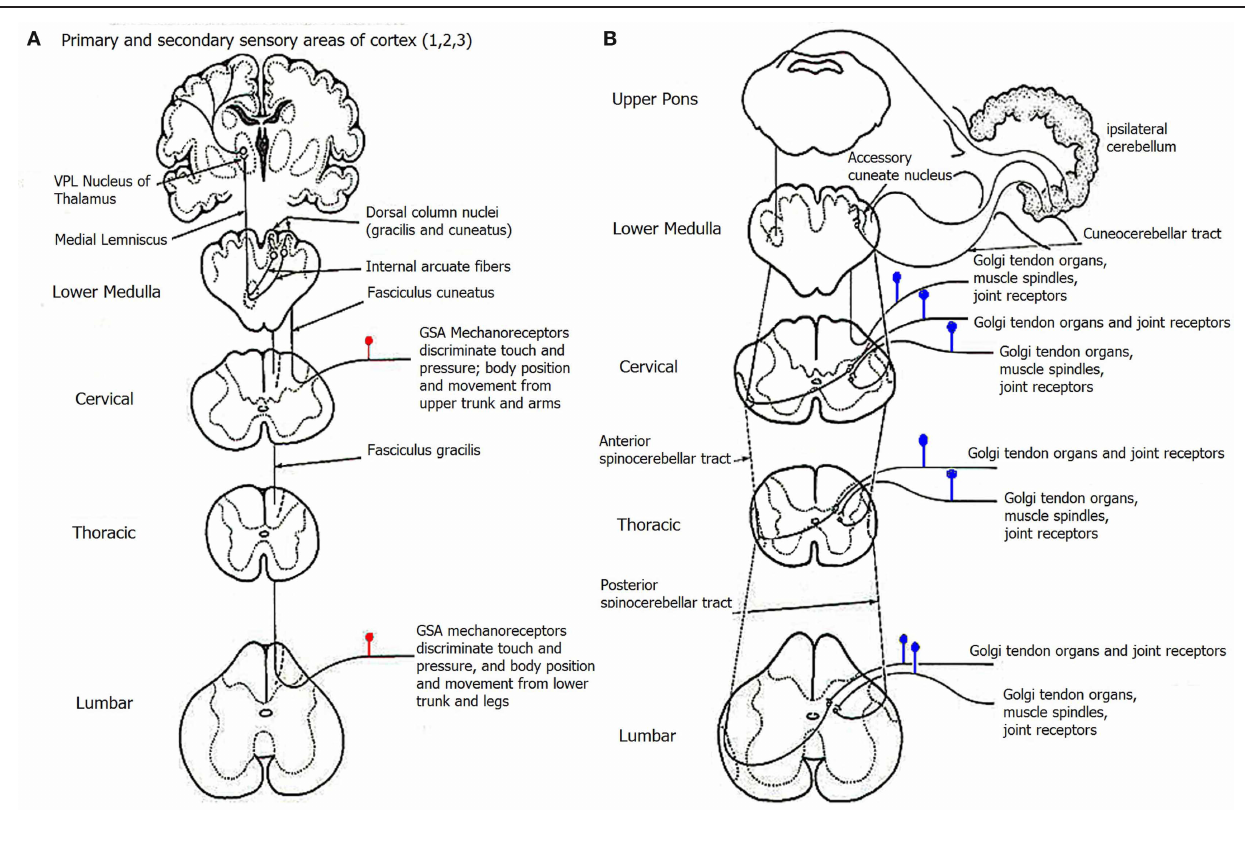
somatosensory cortices (Broadman areas 1, 2, and 3). (B) The so-called unconscious proprioception conveying information about position and movement including dynamics (mass-, forces-, gravity-, and fine internal timing-related information) through Golgi tendon organs, joint receptors, and muscle spindles. Synapses along the way carry information with targets at cerebellar